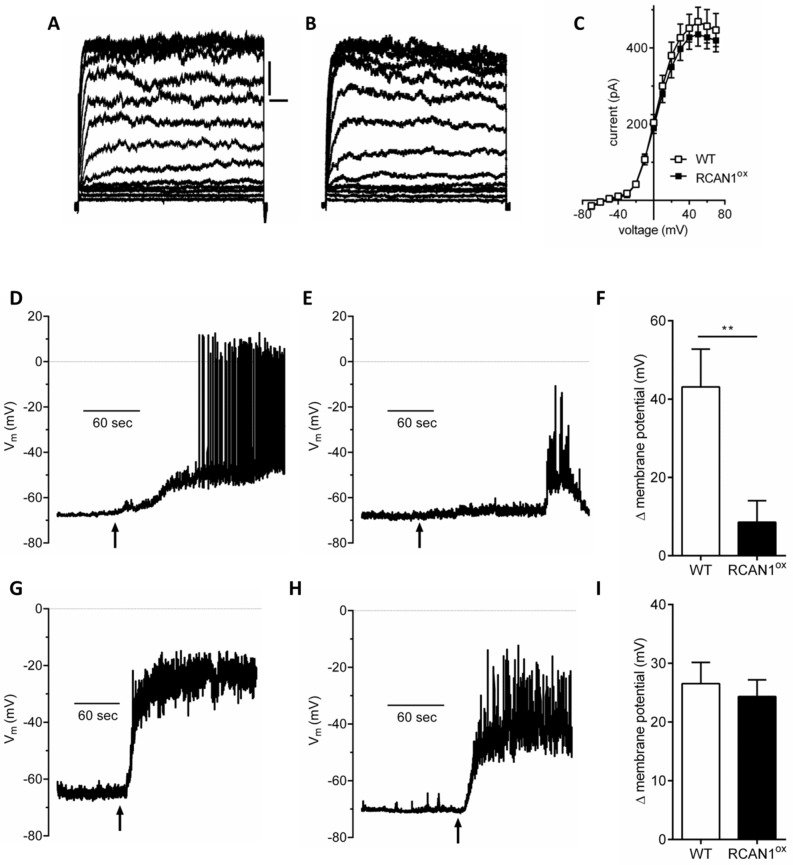
Glucose-dependent membrane depolarisation is reduced in RCAN1ox β-cells.Voltage clamp recordings in (A) WT and (B) RCAN1ox β-cells. Scale bar in A is 20ms and 20pA in A and B. (C) Current-voltage relationship in WT (n = 59) and RCAN1ox (n = 39) β-cells. Current clamp recordings from (D) WT and (E) RCAN1ox β-cells in response to 20mM glucose (arrow). (F) Membrane potential change in response to 20mM glucose in WT (n = 6) and RCAN1ox (n = 7) β-cells (**p < 0.01). Current clamp recordings from (G) WT and (H) RCAN1ox β-cells in response to tolbutamide (100μM, arrow). (I) Membrane potential change in response to tolbutamide in WT (n = 6) and RCAN1ox (n = 6) β-cells.